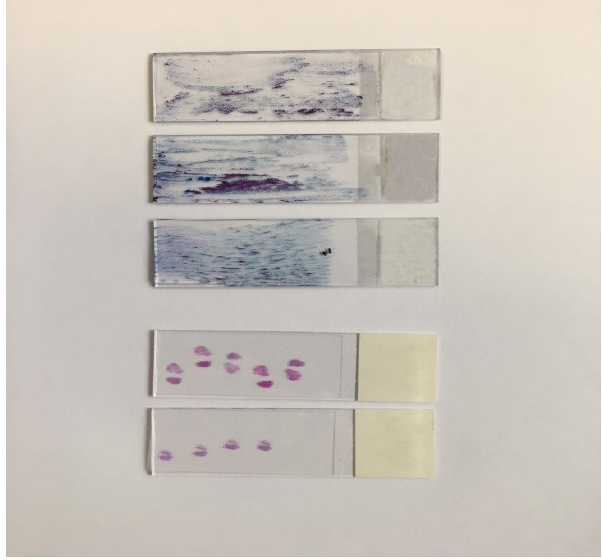
Figure 1. Diagnostic Pap test on three slides and histology tissue section of endocervical curettage